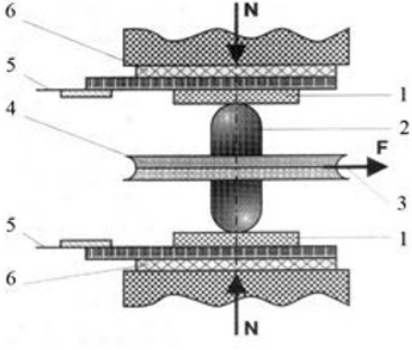
Fig. 2. Model of the setup for the study of tribotechnical properties